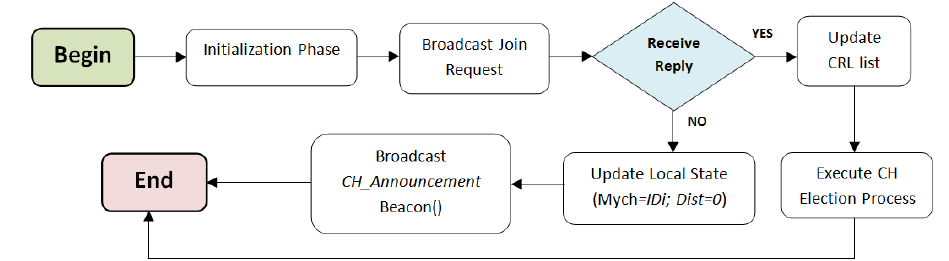
Figure 8. The cluster head joining process.